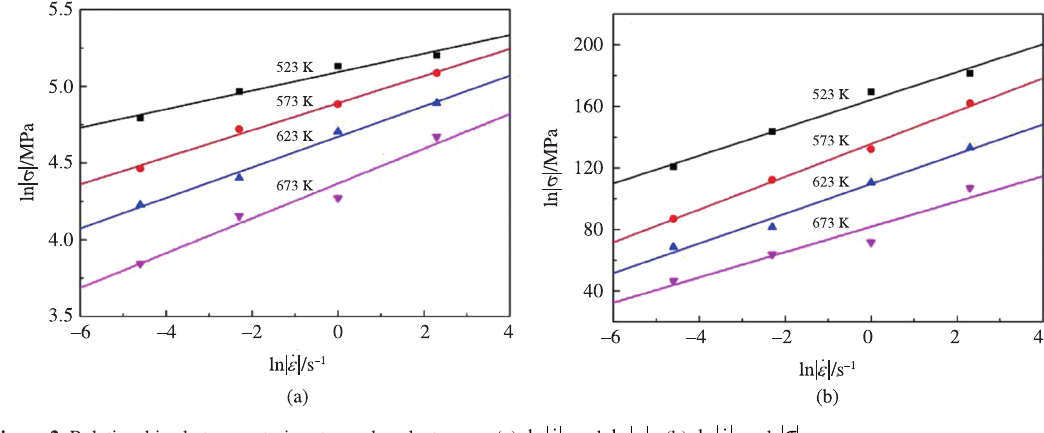
Figure 2. Relationships between strain rates and peak stresses: (a) ln  ε and ln σ ; (b) ln  ε and σ .